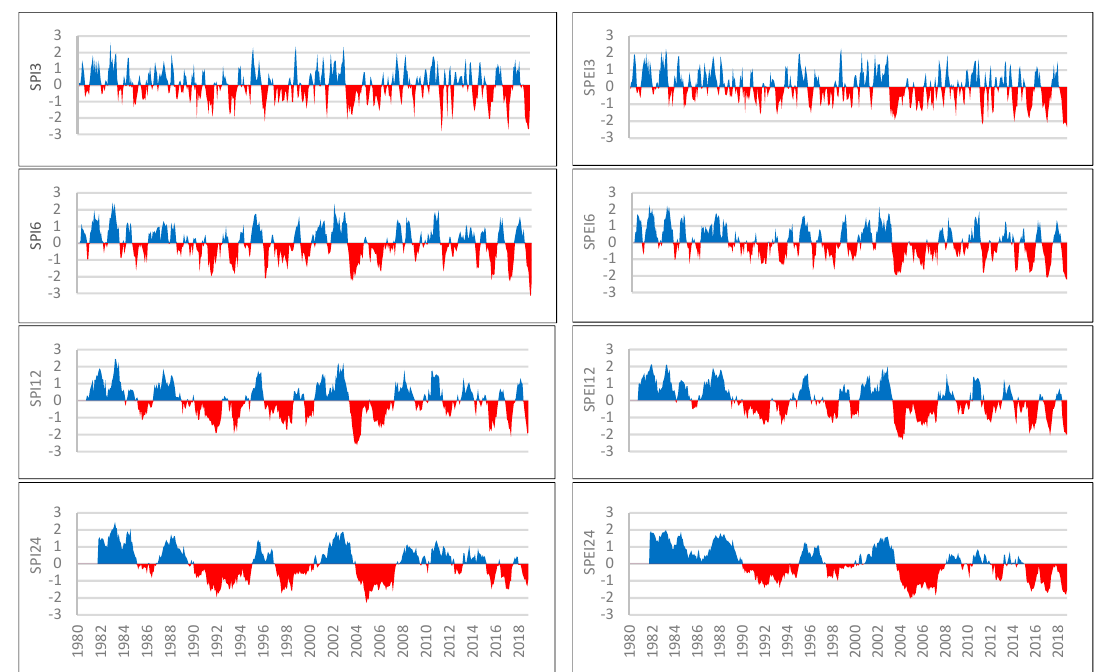
Figure 7. Drought indices SPI and SPEI for 3-, 6-, 12-, and 24 months in GER.